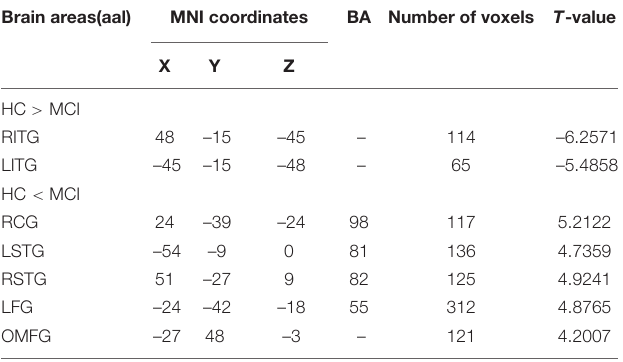
TABLE 3 | Brain areas with different ReHo values between MCIs and HCs.